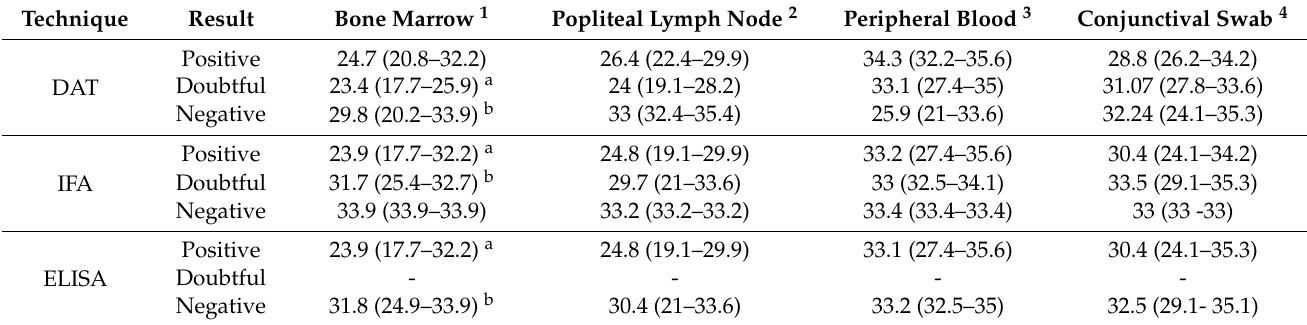
Table 6. Sybr-qPCR results in the different biological samples studied according to serological